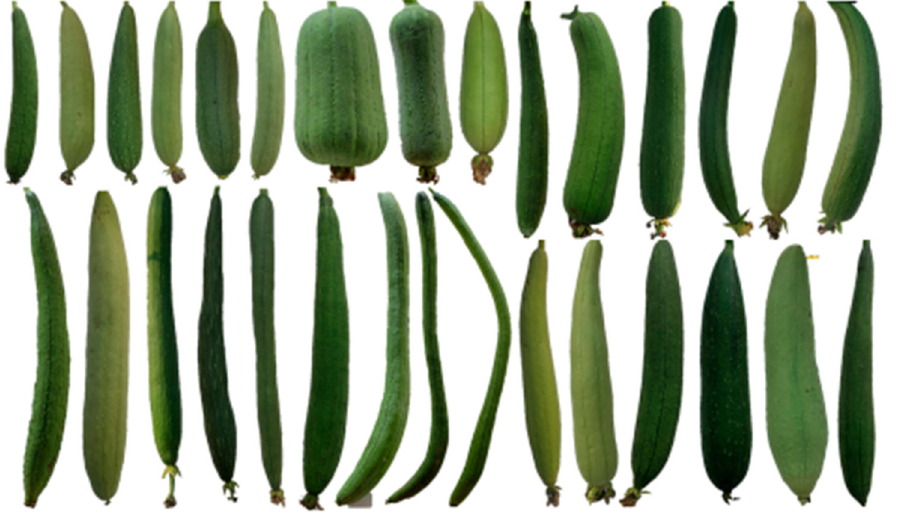
Figure 4. Fruit color and length variability among sponge gourd breeding lines developed at WorldVeg.